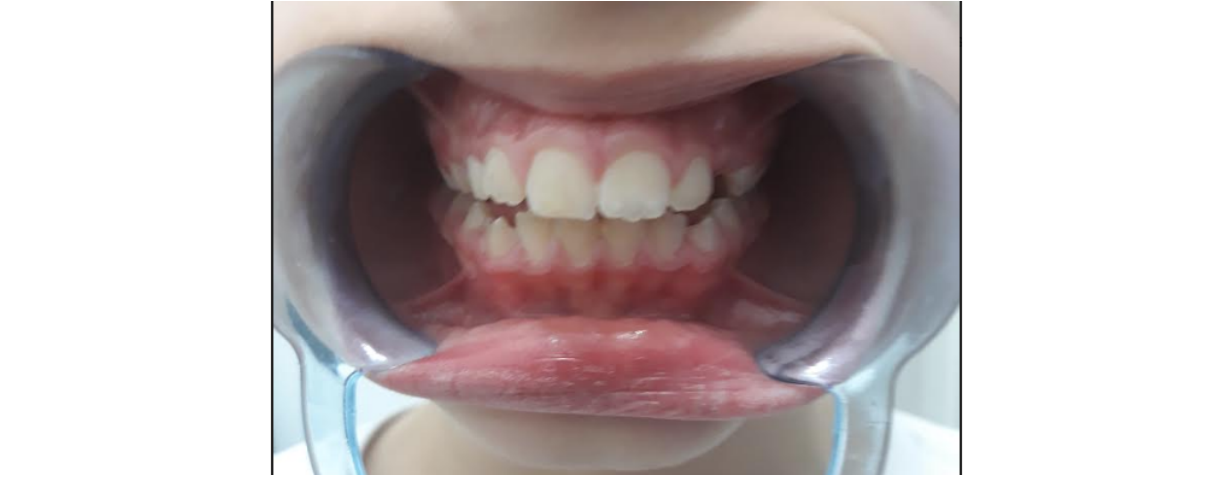
Figure 26. Physical positioning for taking a dental selfie: with a comfortable mouth opener